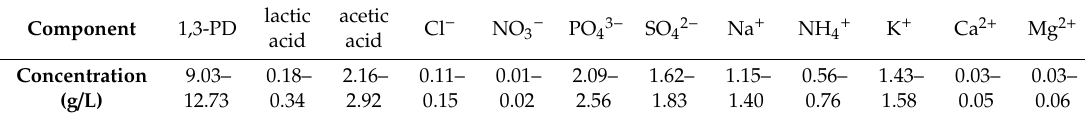
Table 2. The composition of glycerol fermentation broths with Citrobacter freundii bacteria.